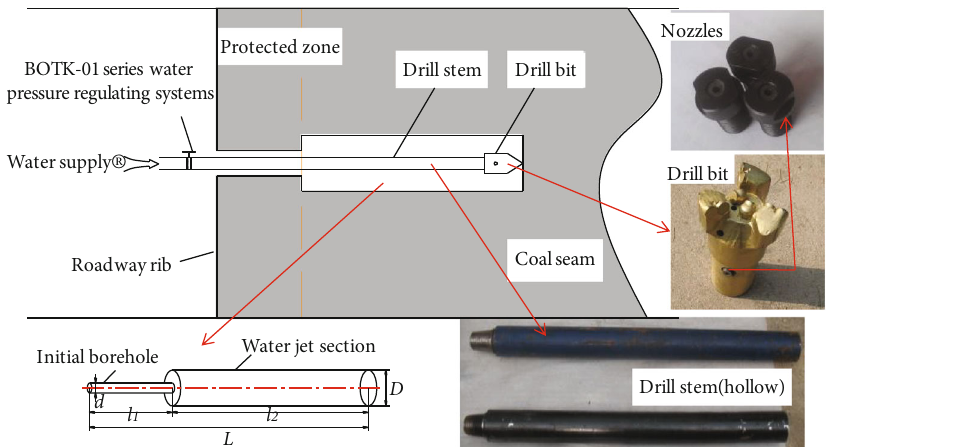
Figure 11: The schematic diagram of water jet technology for roadway rib.